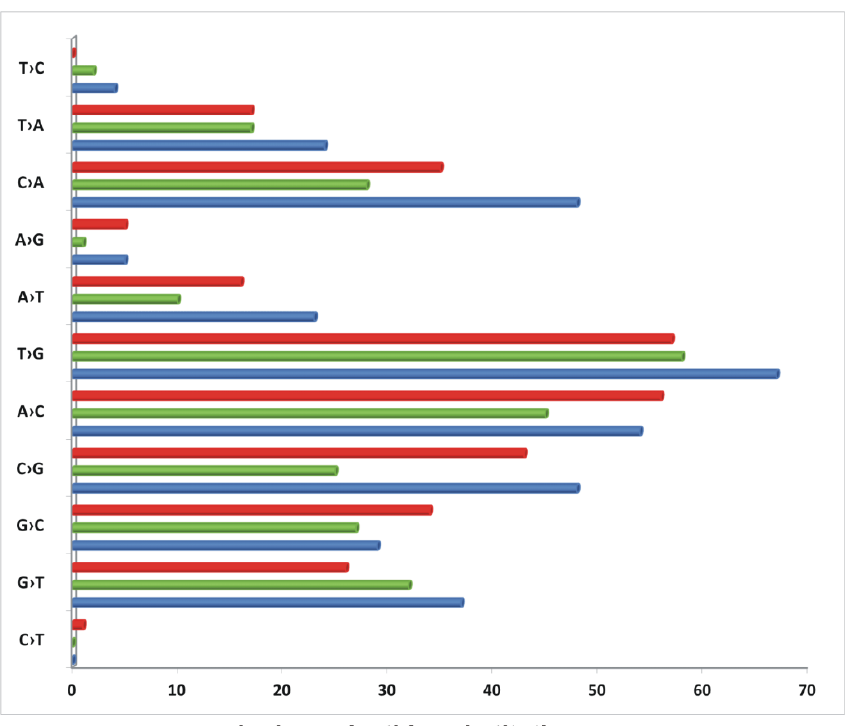
Figure 3. The accumulation of single-nucleotide substitutions in mycobacterial strains growing in the presence of cumene hydroperoxide. The number of SNPs identified in wild-type M. smegmatis (blue), ∆ ku-ligD-ligC 1 -ligC 2 -primC (red), and ∆ ligC 1 -ligC 2 -primC (green) growing in the presence of CHP identified by sequencing the mixture of